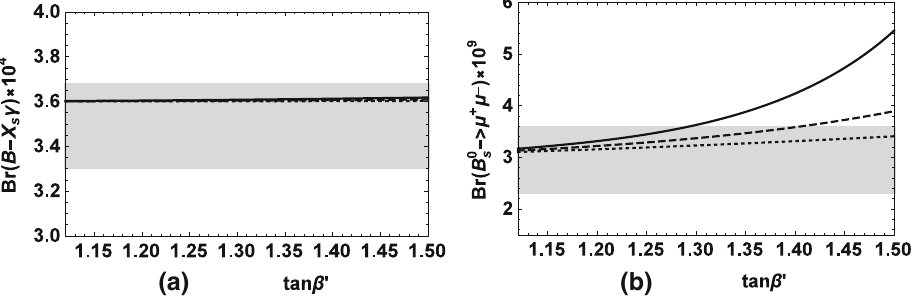
= − 0 . 6 (solid line), g = − 0 . 5 (dashed line), g = − 0 . 4 (dotted YB YB YB